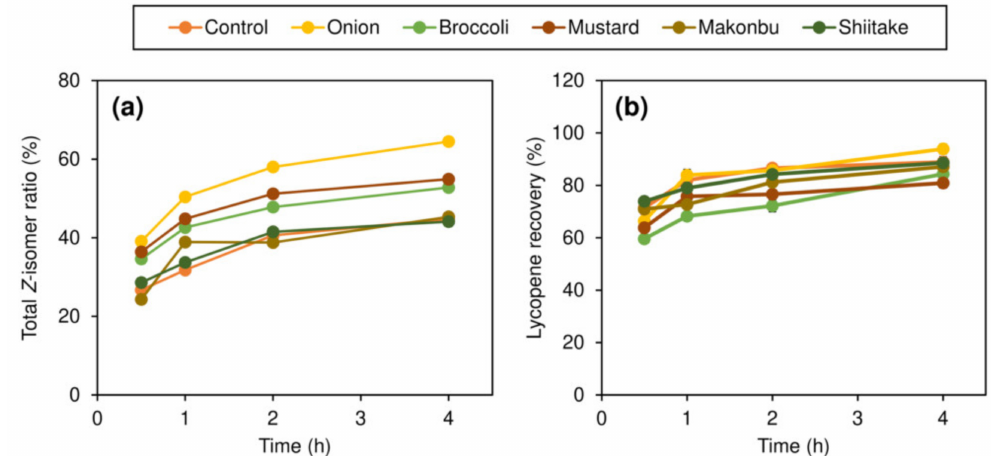
Figure 6. Effects of extraction time and foodstuffs on ( a ) the total Z -isomer ratio of lycopene in the extract and ( b ) the recovery ratio of lycopene. The foodstuffs were added to the extraction process and the extraction was performed using ethyl acetate at 60 ◦ C. Error bars represent mean ± standard deviation ( n = 3).